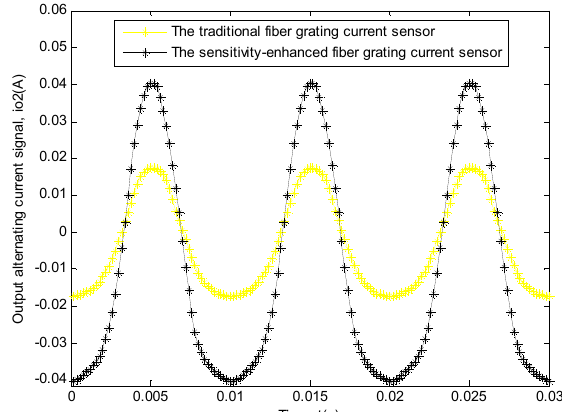
Figure 10. This experiment result of the two sensors between output alternating current signal ( i o 2 ) and time ( t ). The black curve shows the relationship of the sensitivity-enhanced fiber grating current sensor. The yellow curve shows the relationship of the traditional fiber grating current sensor.